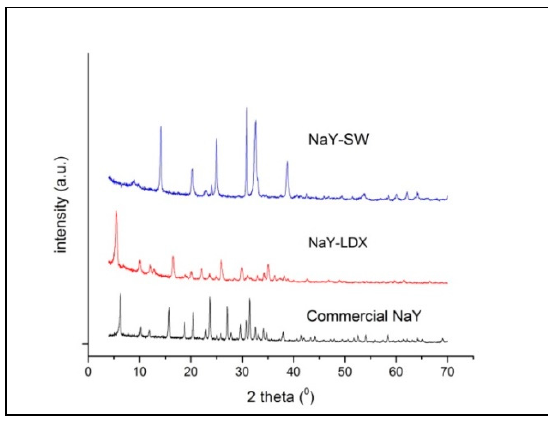
Figure 5. XRD data of as-synthesized NaY seeds synthesized using silica water ( top ) and LUDOX ( middle ) compared with commercial NaY ( bottom ).